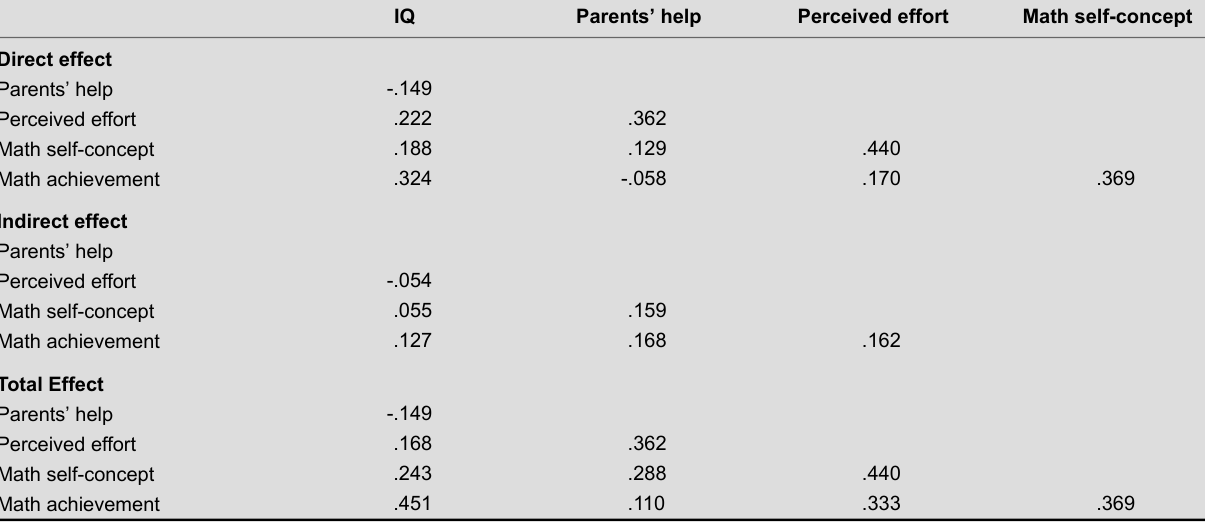
Direct, Indirect and Total Effects of Variables on Math